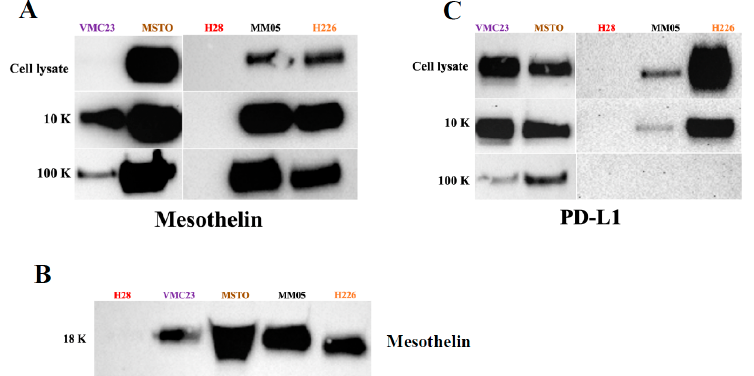
Figure 11. Western blot analysis showing ( A ) the presence of mesothelin in the 10 K and 100 K EVs of mesothelioma cell lines, ( B ) presence of mesothelin in the 18 K EVs of mesothelioma cell lines, and ( C ) presence of PD-L1 in the 10 K EVs of mesothelioma cell lines. Original blot see Supplementary File S1.